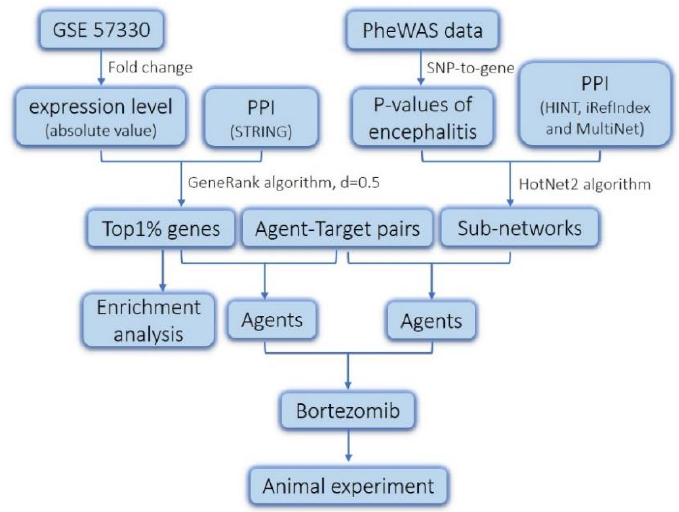
Figure 1. The pipeline for gene screening and drug repurposing. The dataset GSE57330 obtained from GEO database. The protein-protein interaction (PPI) network used in the HotNet2 algorithm was obtained from HINT, iRefIndex, and MultiNet. The protein-protein interaction (PPI) network used in the GeneRank algorithm was derived from the STRING